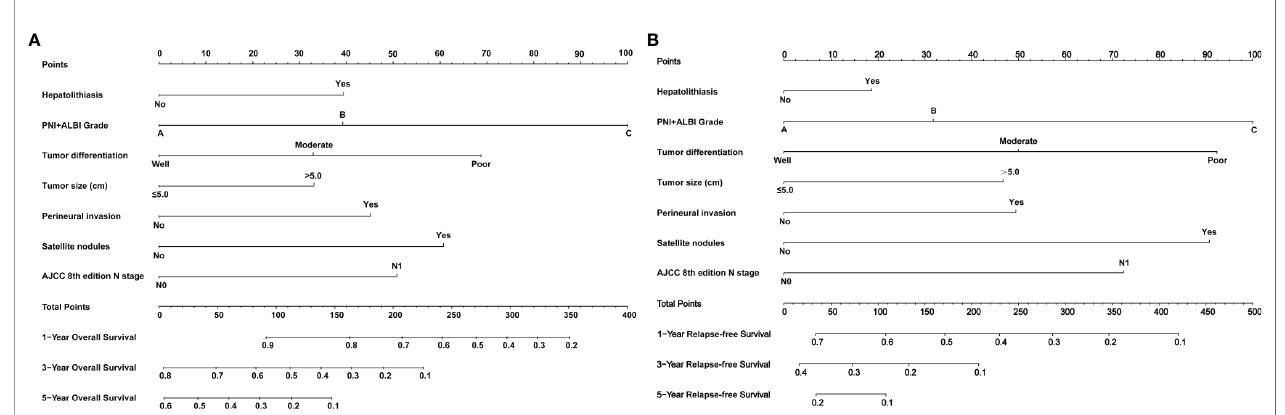
FIGURE 4 | Nomogram prediction models for predicting the overall survival (OS) and recurrence-free survival (RFS) of patients with intrahepatic cholangiocarcinoma (ICC) after radical resection. (A, B) Nomograms for predicting the OS (A) and RFS (B) of patients with ICC after